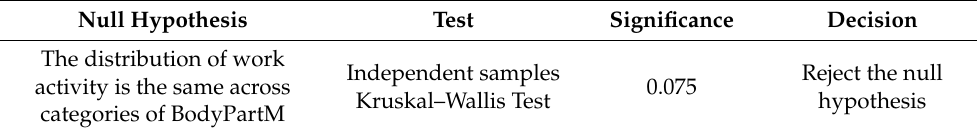
Table 8. Hypothesis test summary.